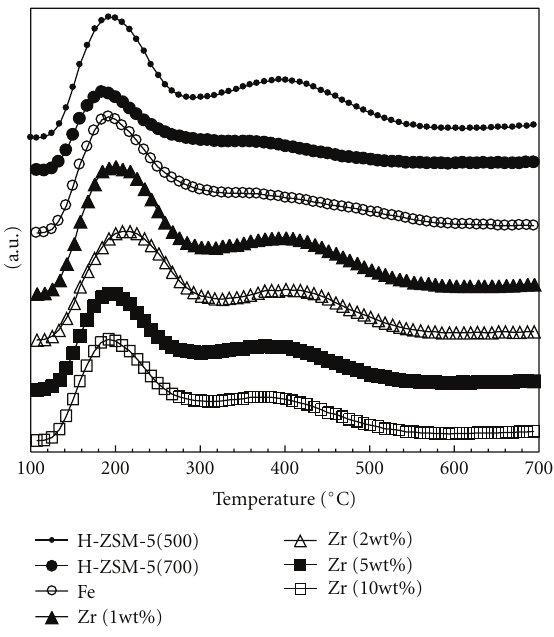
Figure 4: NH 3 -TPD profiles of H-ZSM-5 and (Fe or Zr)/H-ZSM-5